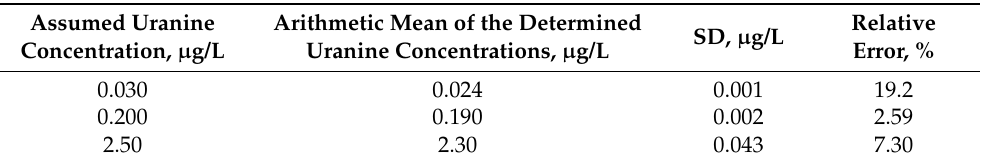
Table 9. Results of measurements and calculations performed to determine the correctness of the method for determining uranine in liquid